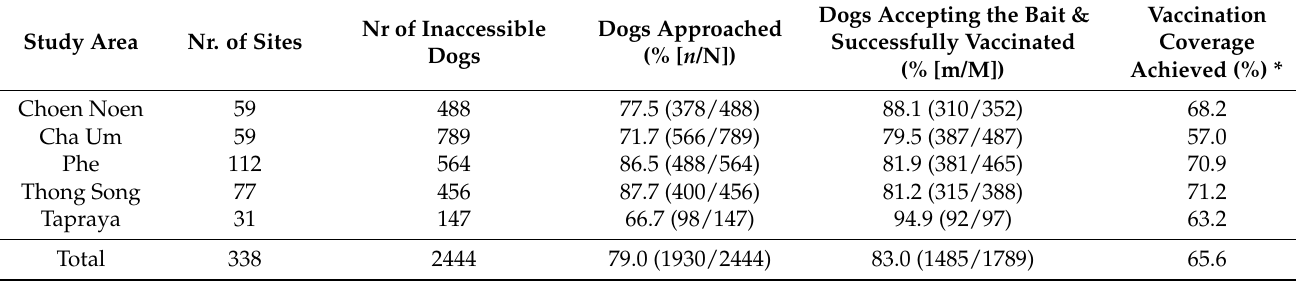
Table 2. Achieved oral rabies vaccination coverage in the free-roaming dog population at the identified sites in 5 study areas.